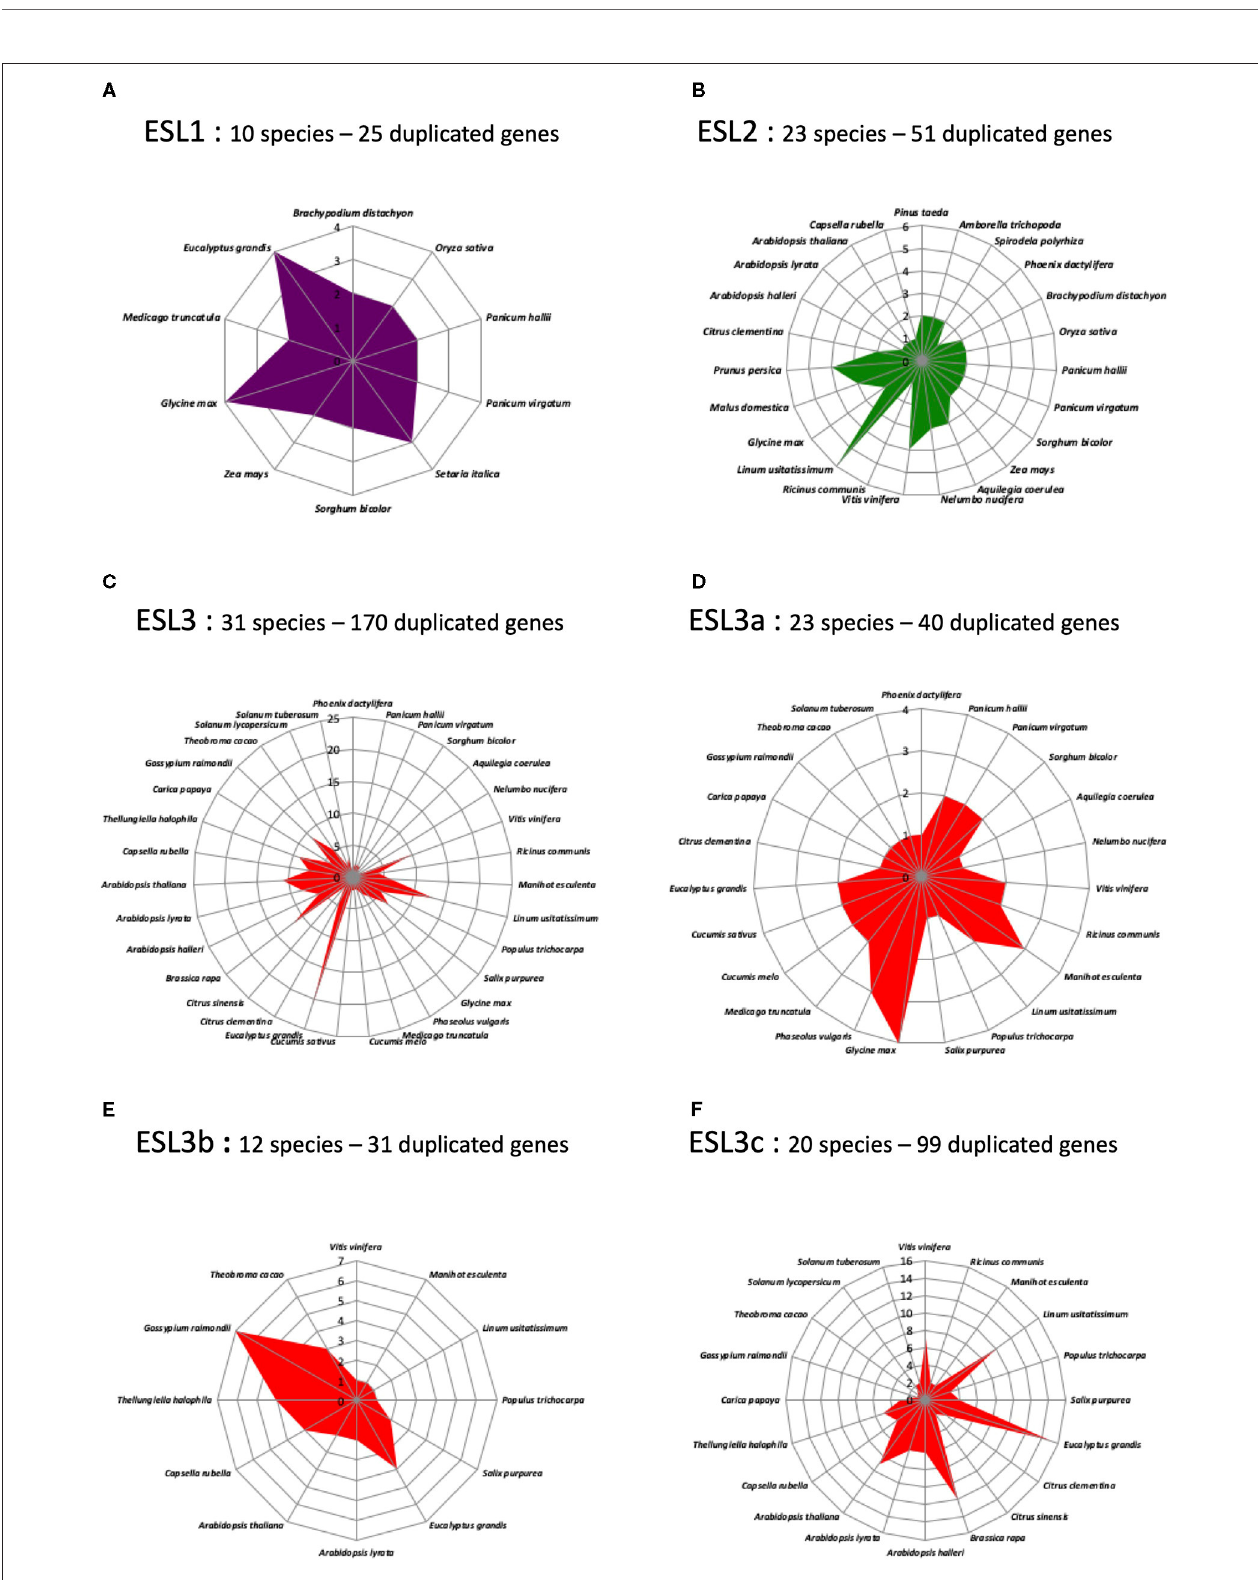
FIGURE 7 | The distribution of the tandem duplicated ESL genes in the different ESL groups. Values correspond to the number of tandem duplicated genes for each species. (A) ESL1 , (B) ESL2 , (C) ESL3 , (D) ESL3a , (E) ESL3b , and (F) ESL3c .